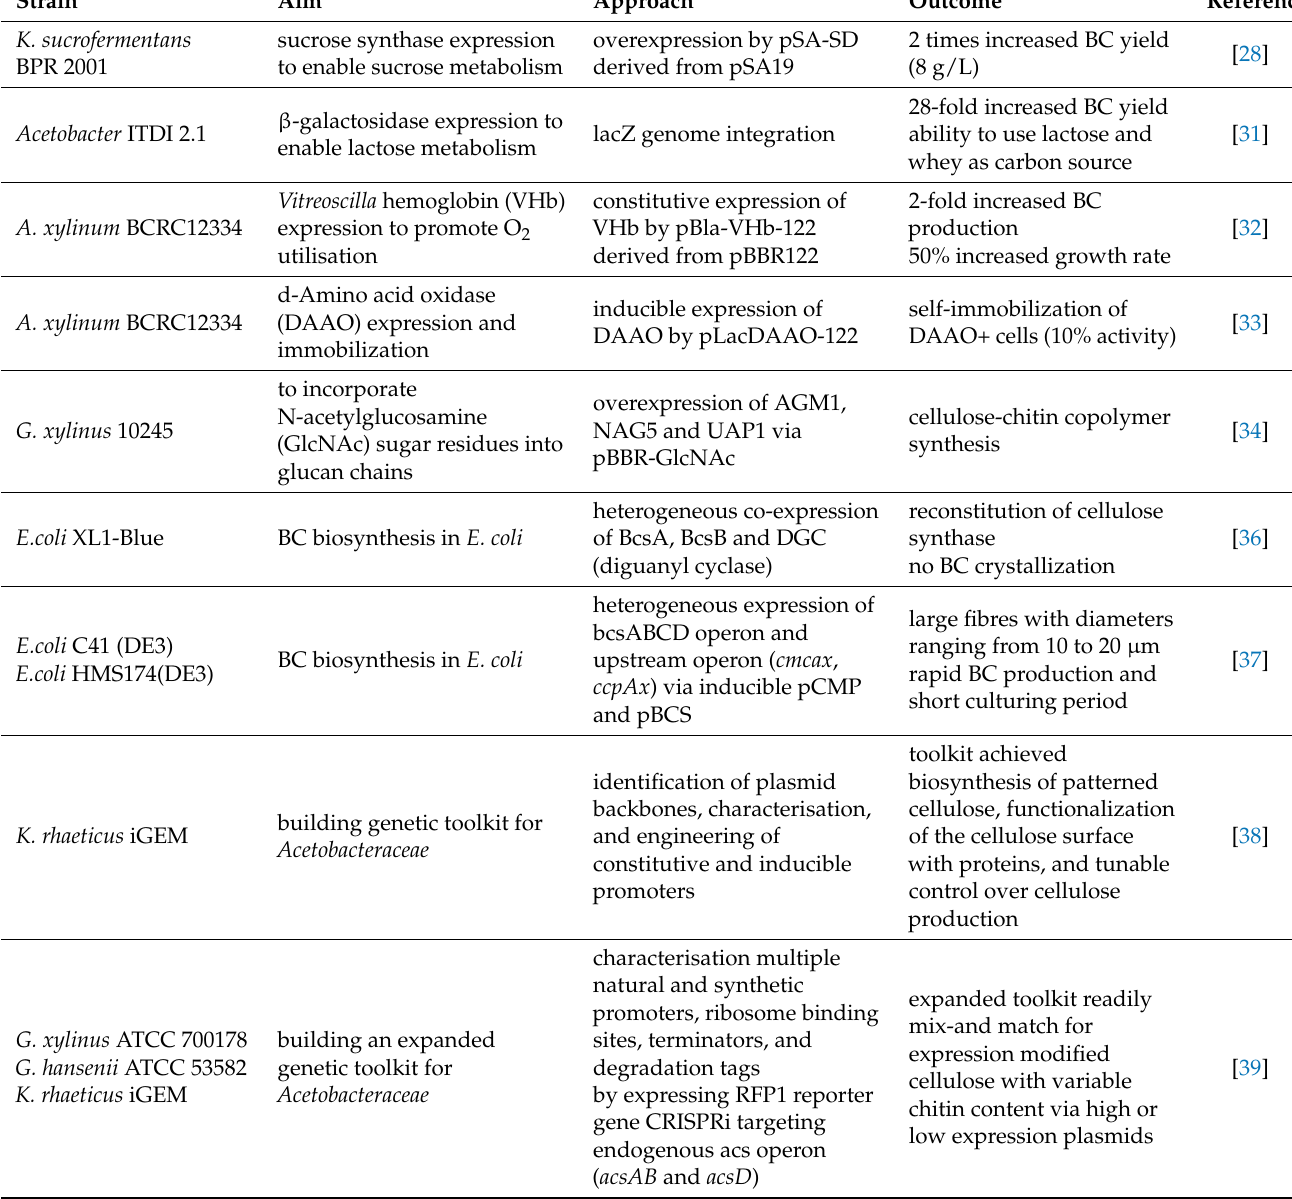
Table 1. Different approaches used for engineering BC biosynthesis